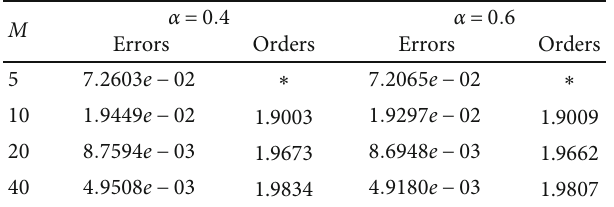
Table 4: The errors and orders in temporal and spatial direction by using L-FEM.